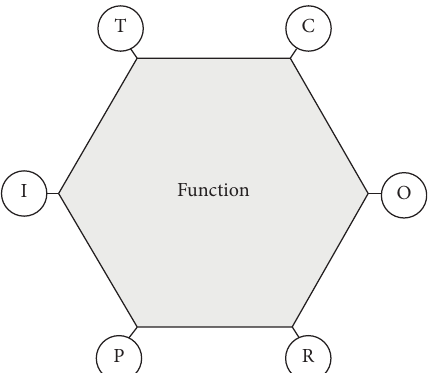
Figure 1: A hexagon representing a function, with the six aspects of input (I), output (O), preconditions (P), resources (R), control (C), and time